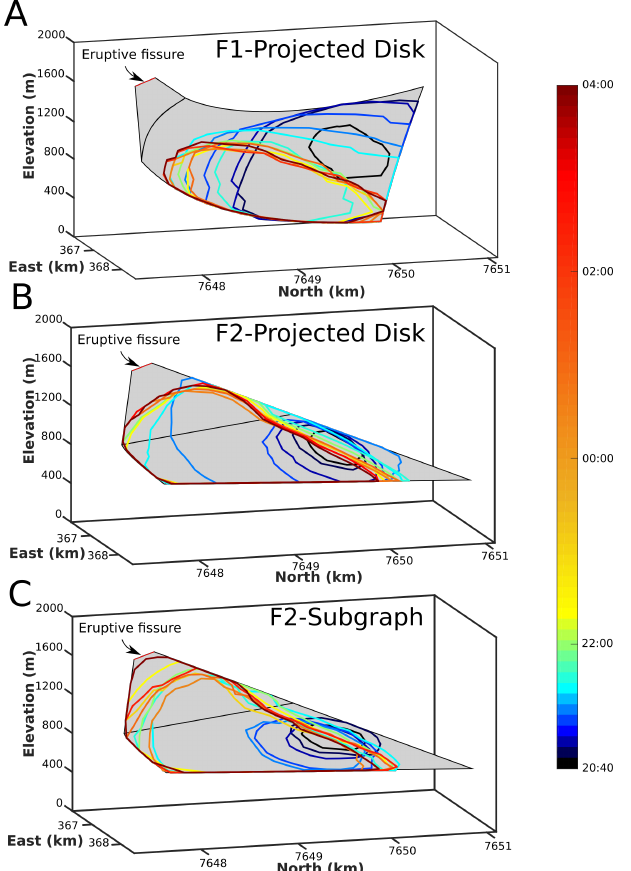
Figure 12. Location of the overpressure source determined from the temporal inversion (colors) for 14 time steps out of the 29 time steps inverted between 20:40 on 25 May and 04:00 the next day. The pressurized area is assumed to be a circular disk projected on the a priori mesh (in gray) of family F1 ( A ) and family F2; ( B ) or a subgraph of the a priori mesh of family F2; ( C ). Source geometries for F1 and F2 are non unique solutions determined from the inversion of the four sets of InSAR data that cover the whole